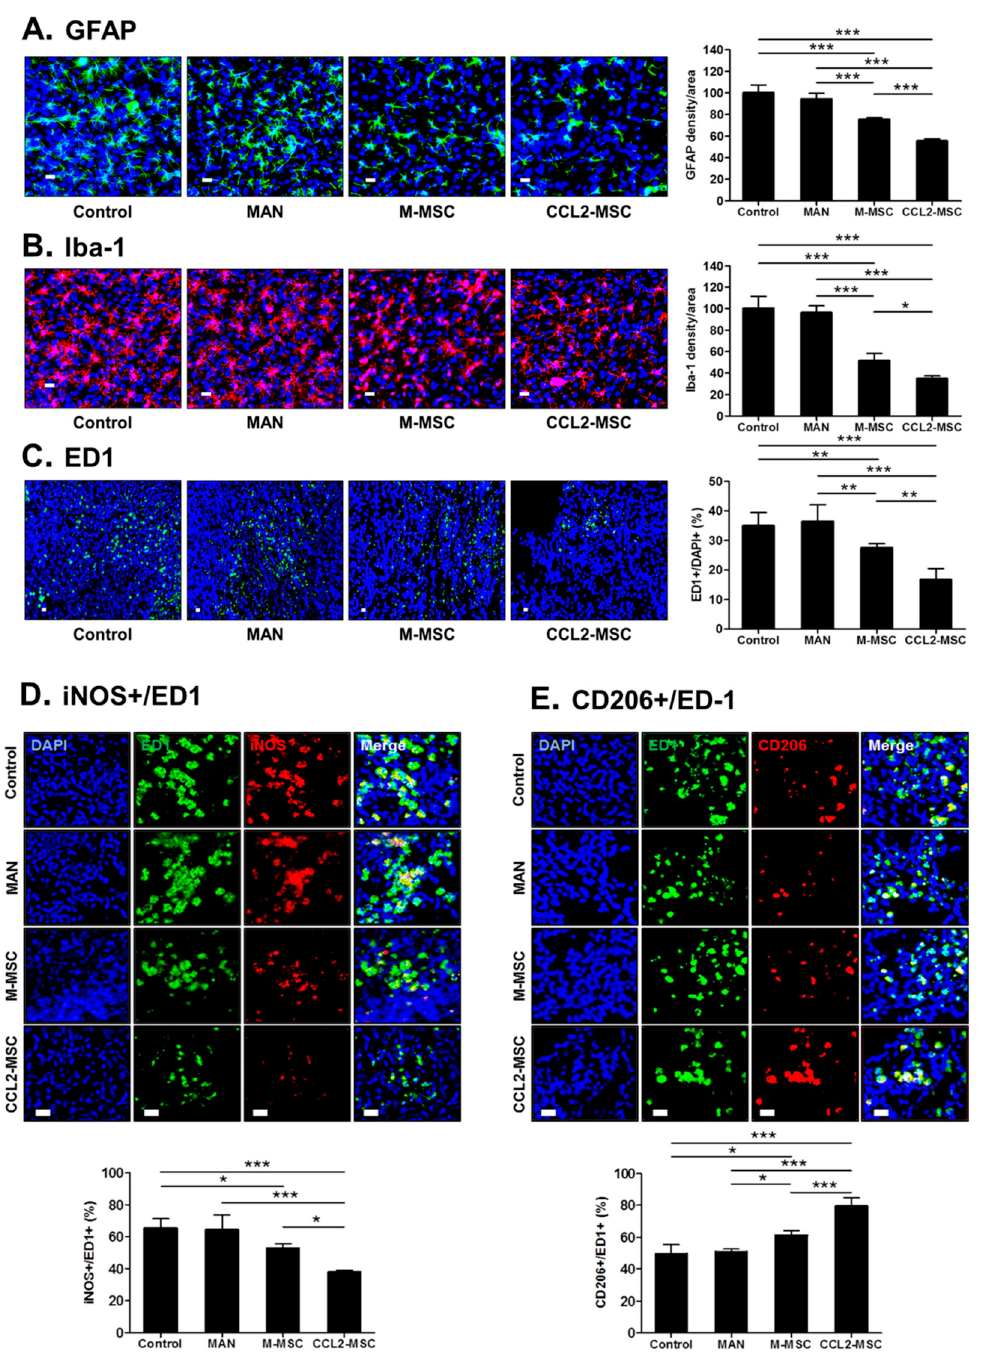
Figure 7. Changes in inflammation in the peri-infarct area following hUC-MSC transplantation. Immunostaining analyses were performed 28 days after MCAo induction. ( A ) Images showing GFAP + cells in the peri-infarct area. The graph shows the density of GFAP + cells per area in each group. ( B ) Representative immunostaining images showing Iba-1 + cells in the peri-infarct area. The graph shows Iba-1 + cells per area in each group. ( C ) Representative immunostaining images showing ED-1 + cells in the peri-infarct area. The graph shows the number of ED1 + cells in each group. ( D , E ) Immunostaining images showing iNOS + cells and CD206 + cells in the peri-infarct area in each group. Each graph shows the iNOS + :ED1 + cell ratio and CD206 + :ED-1 + cell ratio in each group. Data represent the mean ± SEM and were analyzed by one-way ANOVA. * p < 0.05, ** p < 0.01, *** p < 0.001. Scale bar = 20 µm.